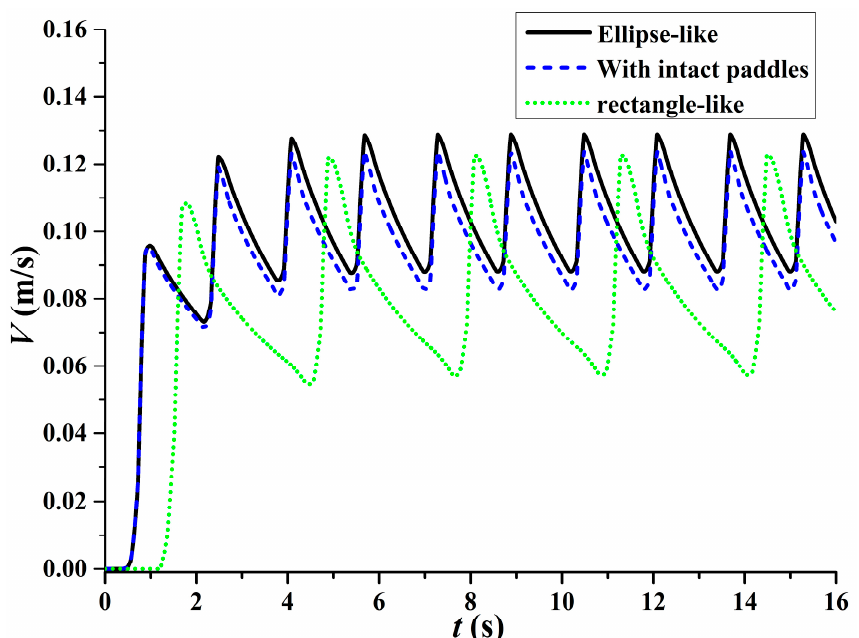
Figure 13. The speeds of the robot as a function of time t in different stroke cycles T . The blue, pink gray, red, and black lines are the speeds of the robot when the stroke cycles are 1.6, 2, 2.4, 2.8 and 3.2 s, respectively.